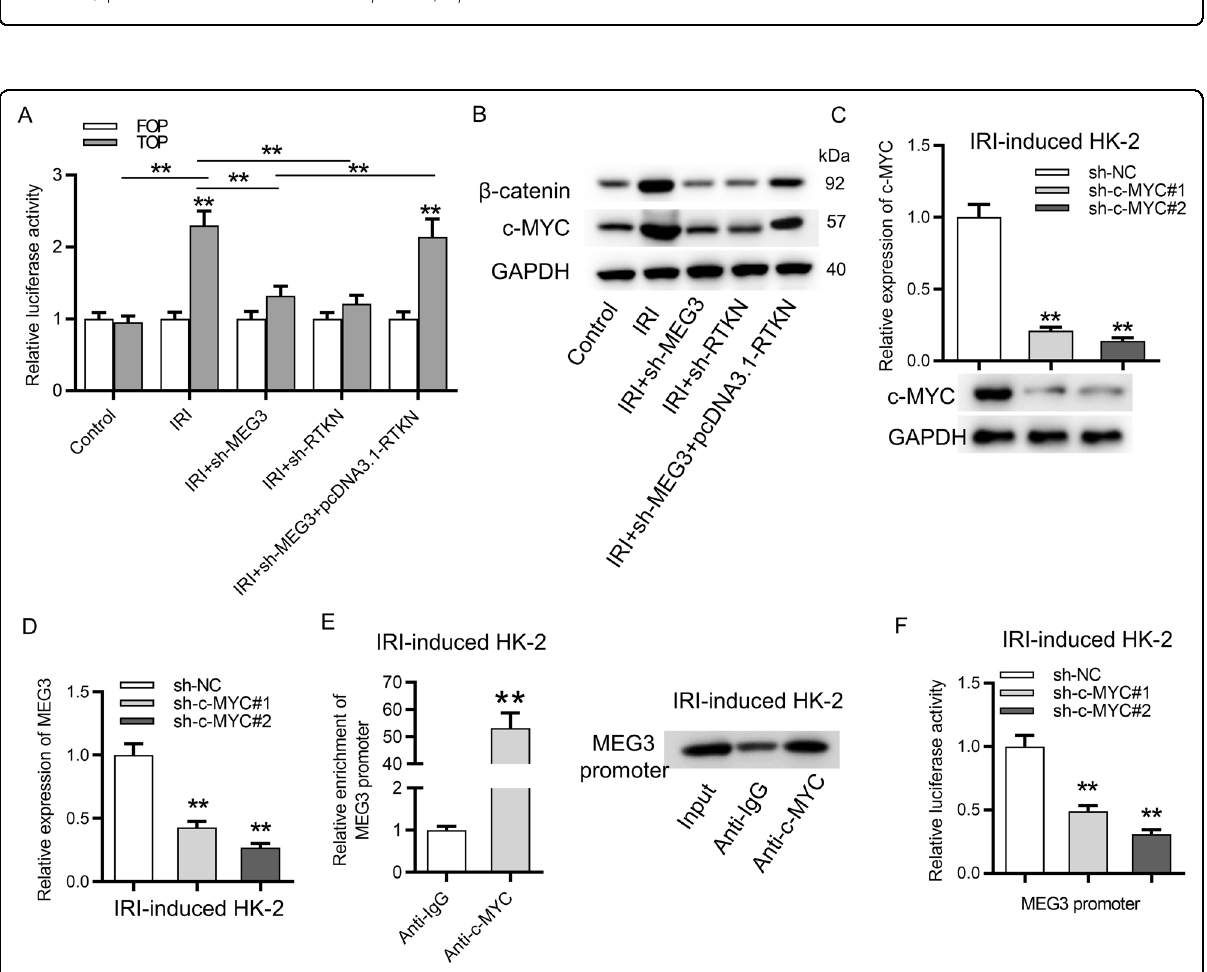
Fig. 8 c-MYC, the downstream effector for the Wnt/ β -catenin pathway, activated the transcription of MEG3. A FOP/TOP luciferase reporter assay revealed the in fl uence of MEG3 and RTKN on the Wnt/ β -catenin pathway in IR-treated HK-2 cells. B Western blot analysis of β -catenin and c- MYC proteins. C Knockdown ef fi ciency of c-MYC was veri fi ed by RT-qPCR and western blot analyses. D The in fl uence of silenced c-MYC on